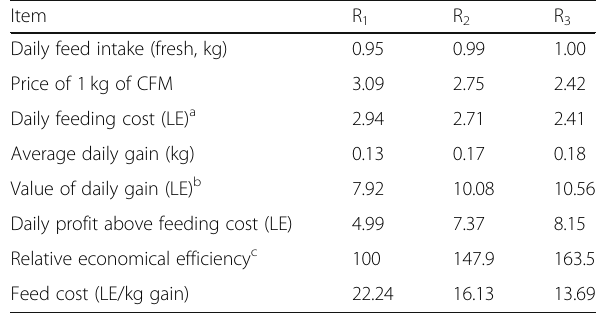
Table 7 Economic evaluation of the experimental